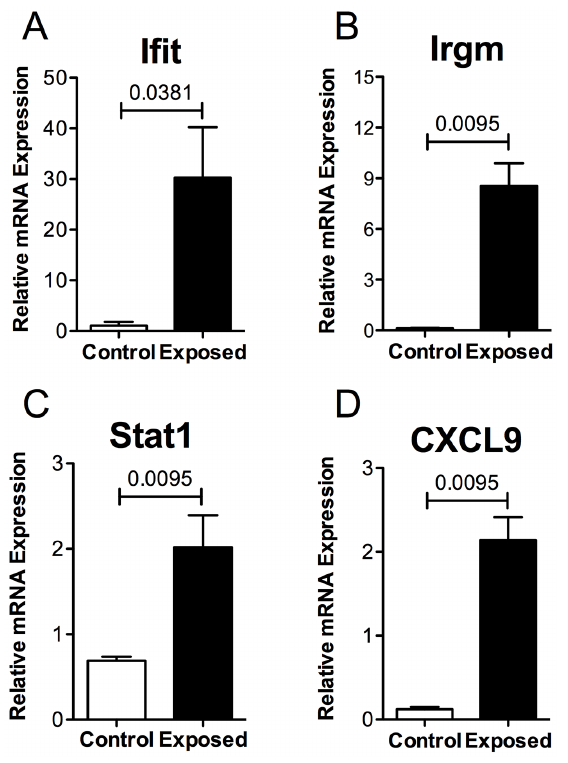
Figure 3. IFN-inducible genes are upregulated in human PBMCs by individuals exposed to sand fly bites. PBMCs from people exposed to Lu. intermedia bites living in an endemic area who expressed high anti-SGS antibody were isolated and stimulated in vitro with SGS (equivalent to 1.5 pairs of salivary glands) for 72 hours. For the control group, PBMCs were isolated from individuals living in a non- endemic area of Salvador, Bahia, Brazil and stimulated with SGS for 72 hours. The expression of (A) Ifit, (B) Irgm, (C) Stat1, and (D) CXCL9 was determined by real-time quantitative PCR. *** p , 0.0001.